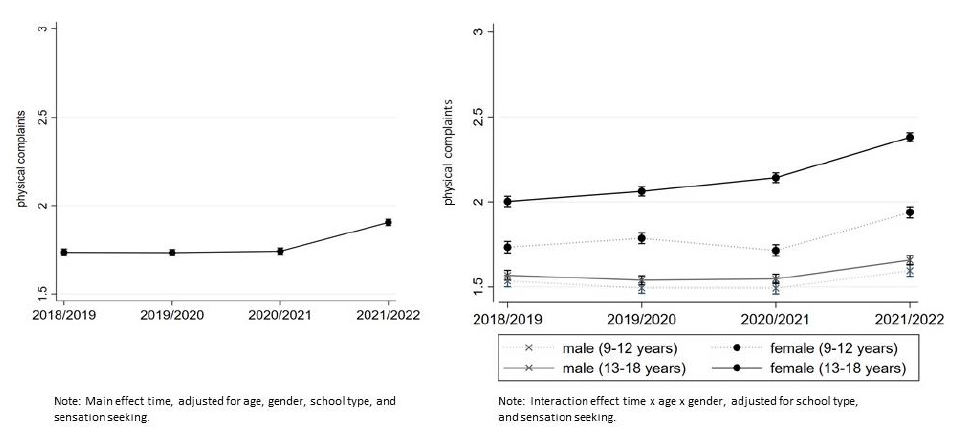
Figure 5. Physical complaints scores from 2018 – 2019 to 2021 – 2022, cross-sectional measures, 2018 – 2019 and 2019 – 2020 pre-pandemic, 2020 – 2021 and 2021 – 2022 pandemic. The scale ranges from 1 (never) to 5 (daily reported physical complaints).